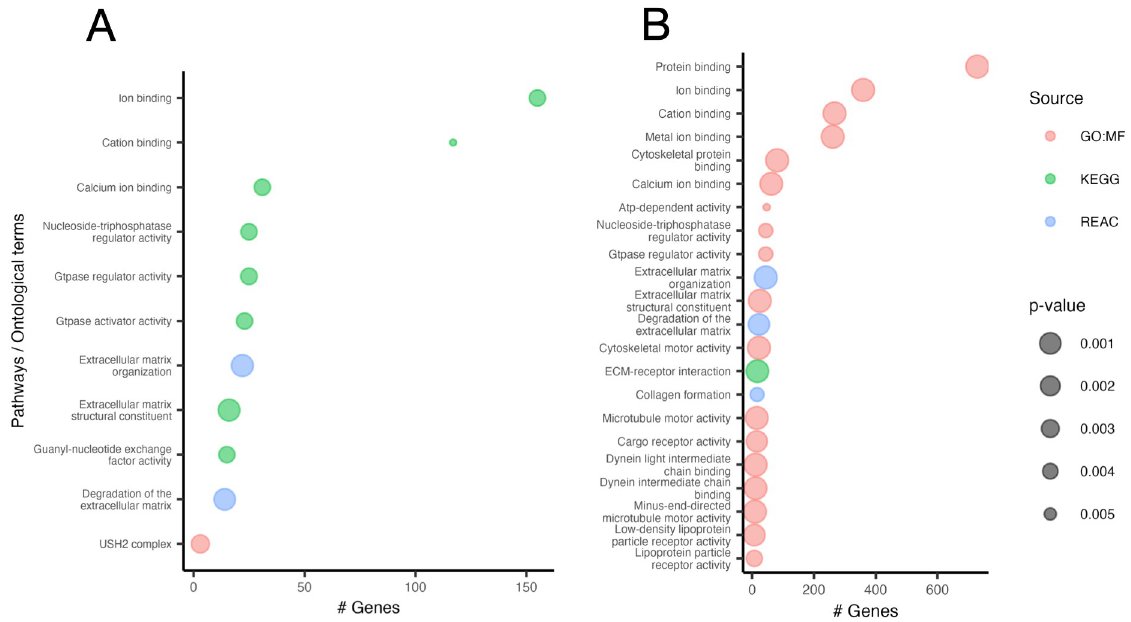
Fig 2. Gene ontology and pathway analysis. Performed on genes from filtered variants detected by the family overlap analysis in at least one family (A) and the TRAPD mutational burden analysis (B). Colours indicate the database used; (red) CORUM: the comprehensive resource of mammalian protein complexes, (green) GO MF: gene ontology for molecular function, and (blue) REAC: Reactome: the comprehensive resource of mammalian protein complexes. Dot size inversely indicates p-value. Only those terms with a p < 0.01 are shown (hypergeometric test). See S2